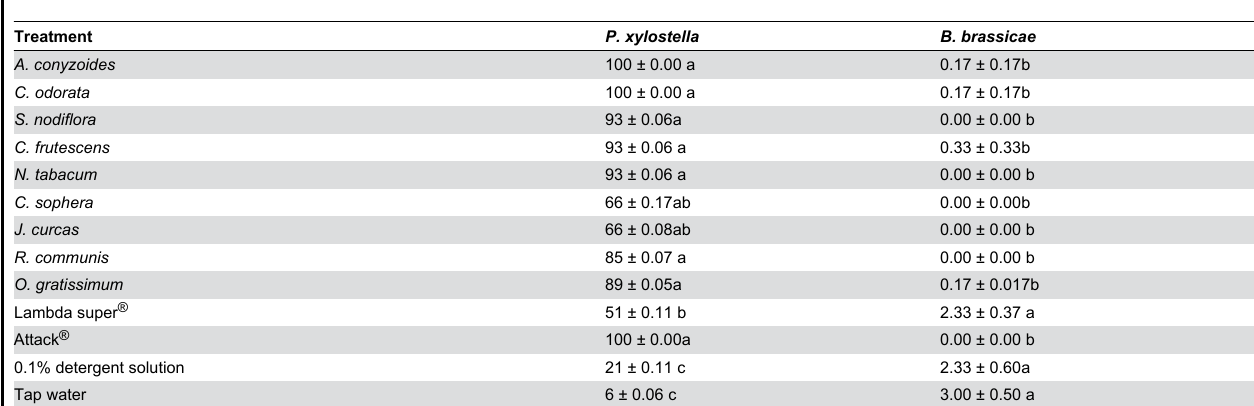
Table 2. Effect of plant extracts and synthetic insecticides on mean (±SE) percentage reduction of Plutella xylostella numbers and Brevicoryne brassicae infestation score (0 = absent to 5 = large continuous colonies) in field cage experiments at Kumasi, Ghana.